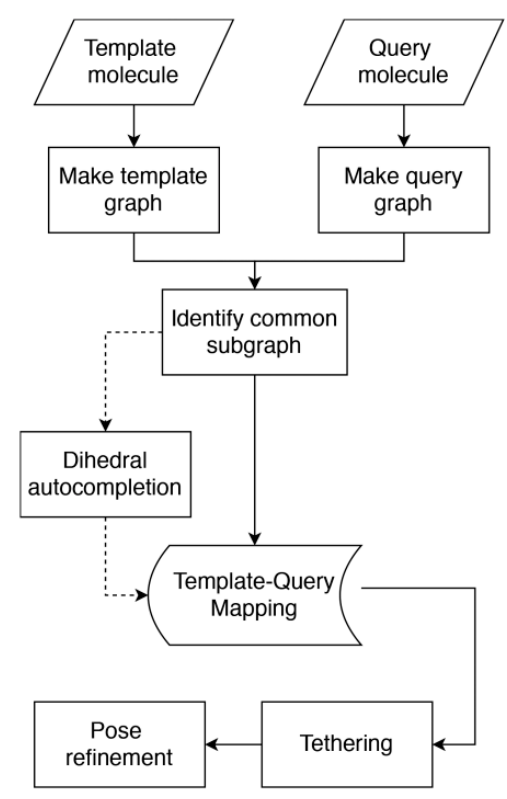
Figure 6. Schematic representation of the flowchart implemented in the SkeleDock algorithm. Reprinted with permission from the American Chemical Society [164].